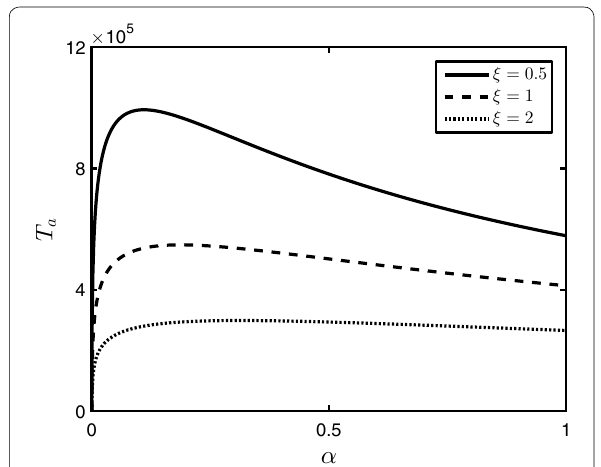
0.7, γ 1, (cid:31) 10 5 and = = =